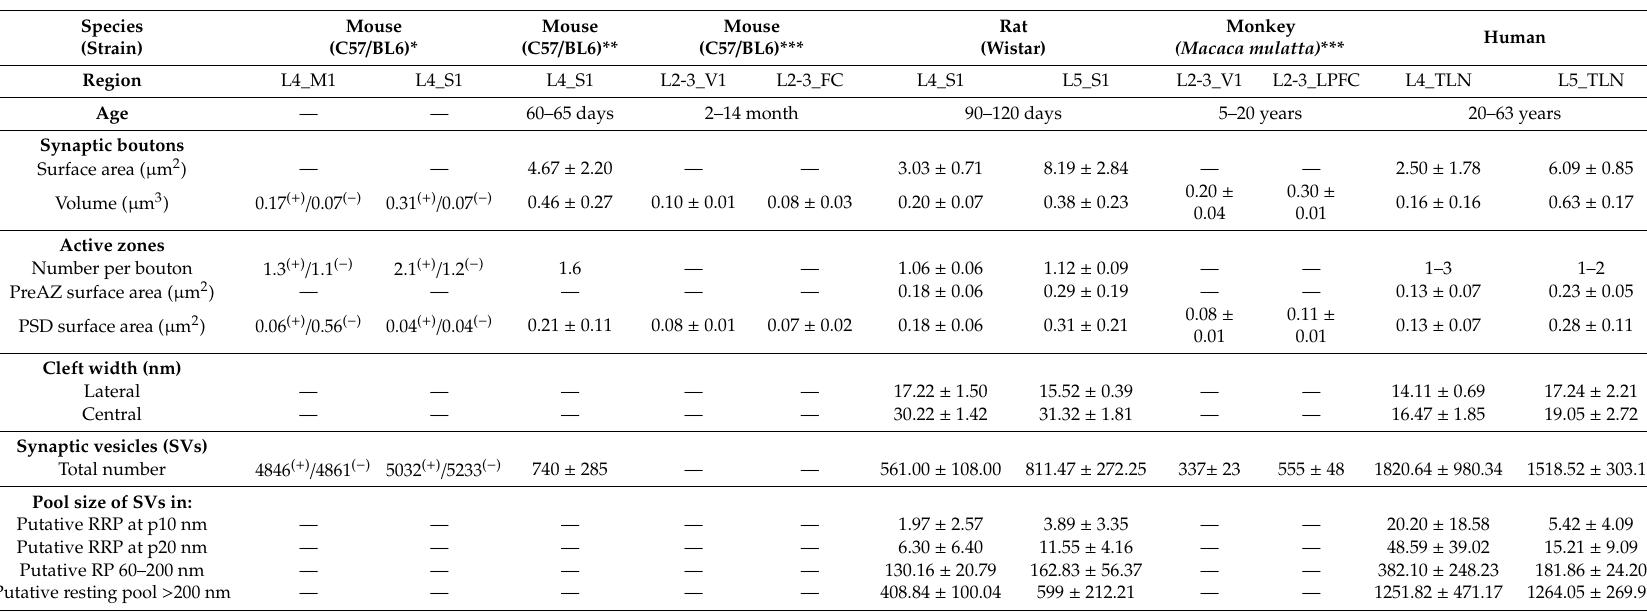
Table 1. Comparison of structural parameters of SBs in di ff erent regions or layers of the rodent, non-human primate, and human neocortex. Species (Strain)